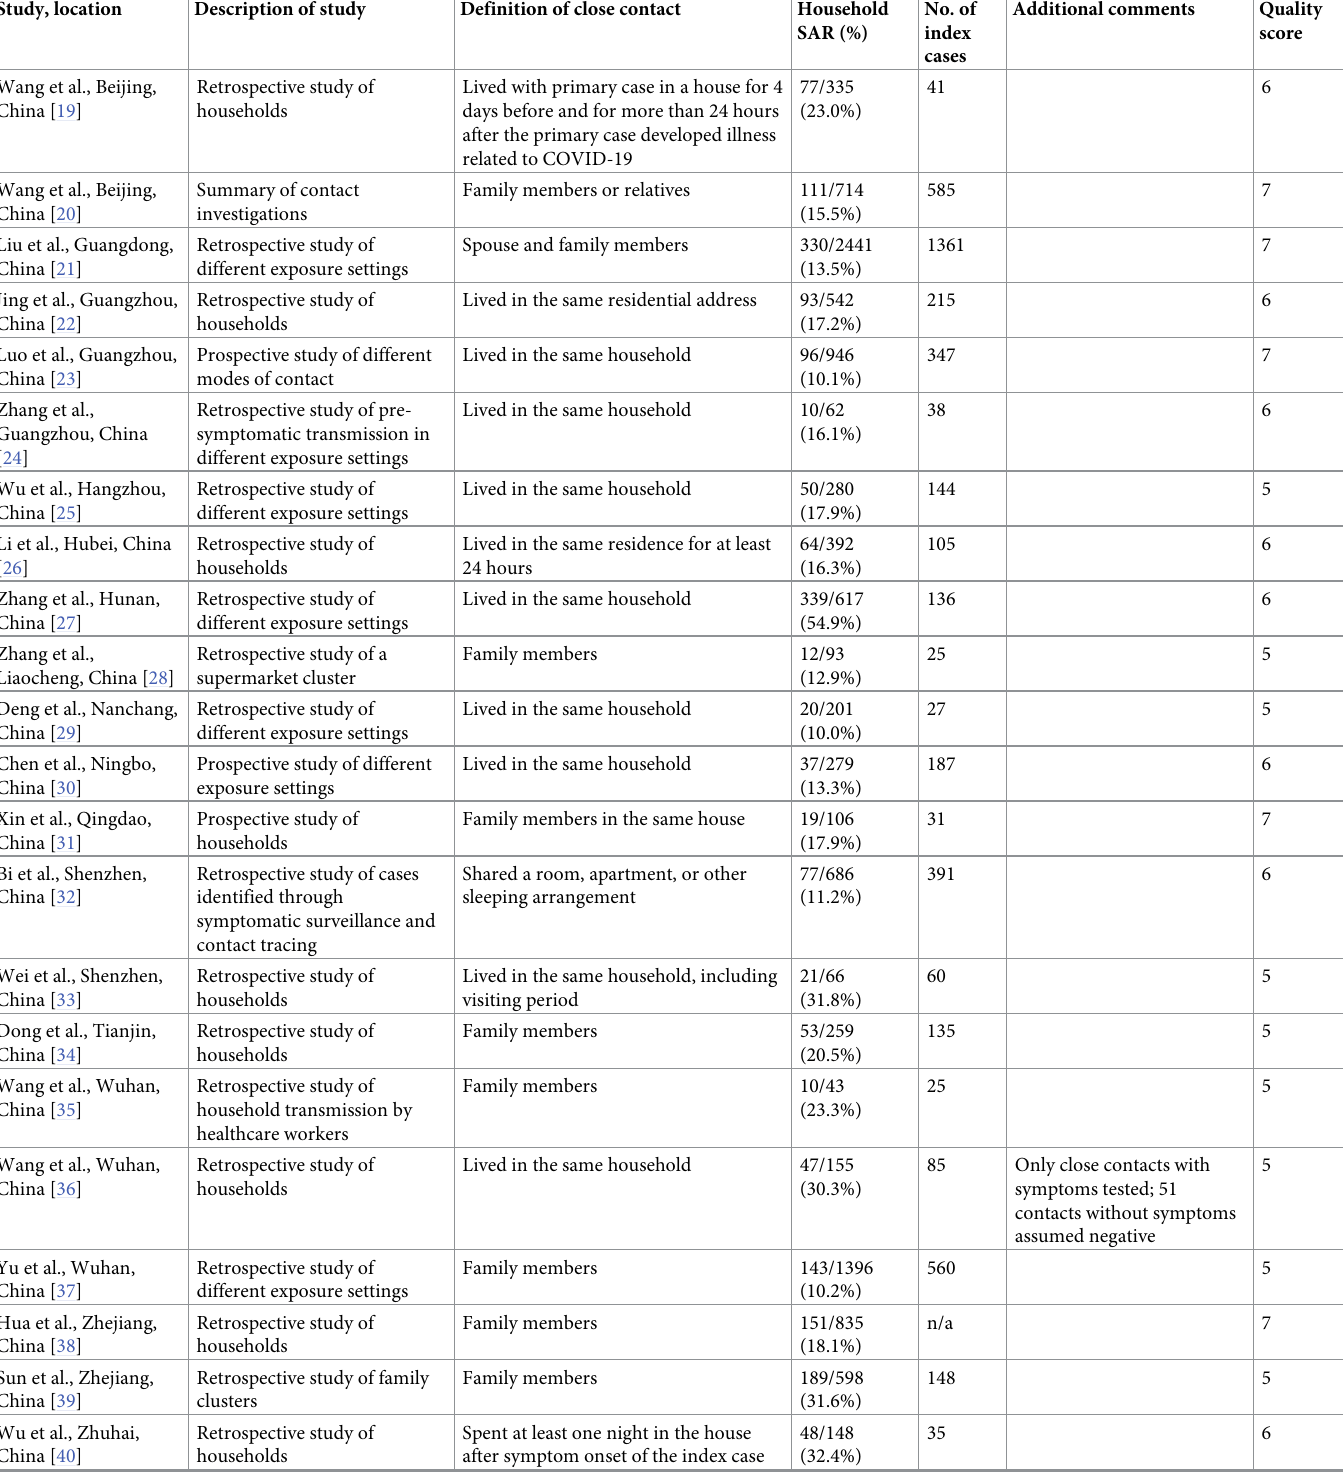
Table 1. Description of studies included in the review and analysis of household secondary attack rate (SAR). Study,